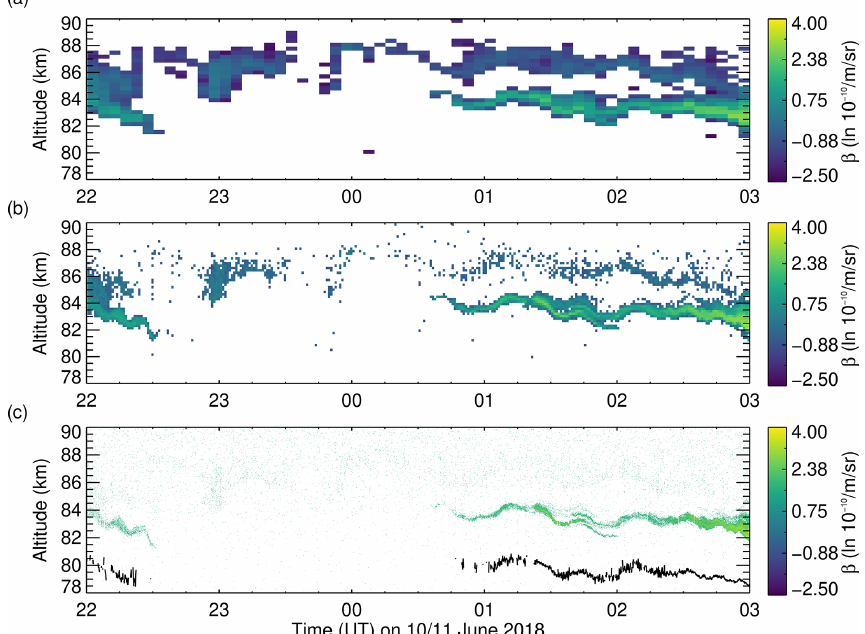
Figure 3. PMC soundings within the period 22:00–03:00UT on 10/11 July 2018 for the three different vertical and temporal resolutions of (a) 300m × 5min, (b) 180m × 1min, and (c) 20m × 10s. The centroid altitude z c is added as a black line to panel (c) and shifted down in altitude by